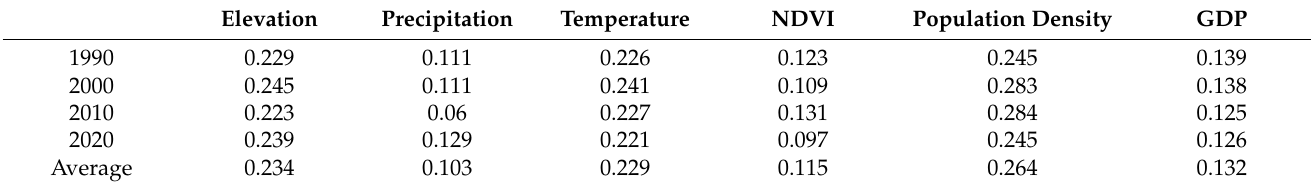
Table 6. The q value of each detection factor varies to land cover change from 1990 to 2020.